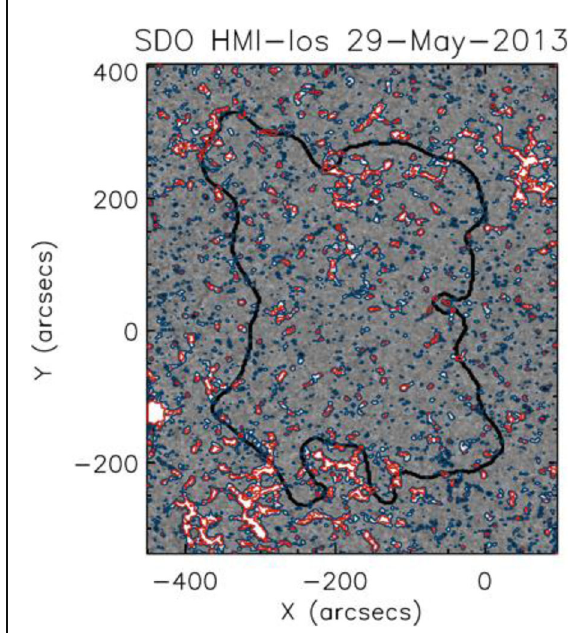
Fig. 32 Magnetogram (scaled to ± 30 G) of a large coronal hole observed on 2013 May 29. The coronal hole boundaries are outlined in black. Regions with an absolute magnetic field density of more than 10 G are outlined in blue and of more than 50 G in red. Taken from Hofmeister et al. (2017)